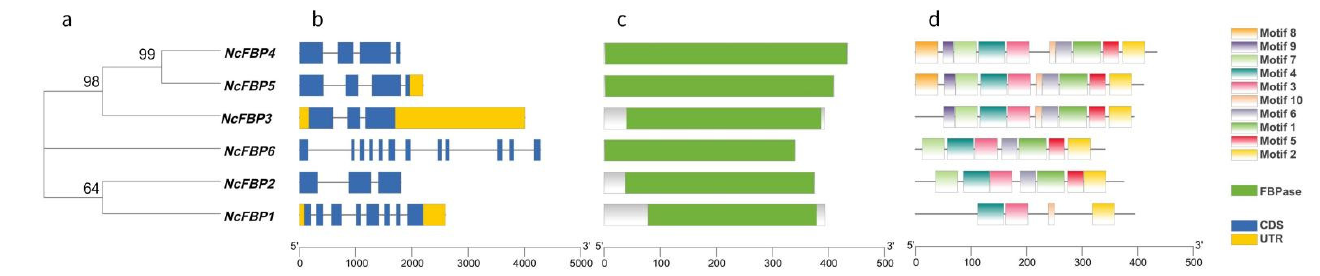
Figure 1. Phylogenetic relationships, gene structure, domains and motifs of FBP family in N. cadamba .